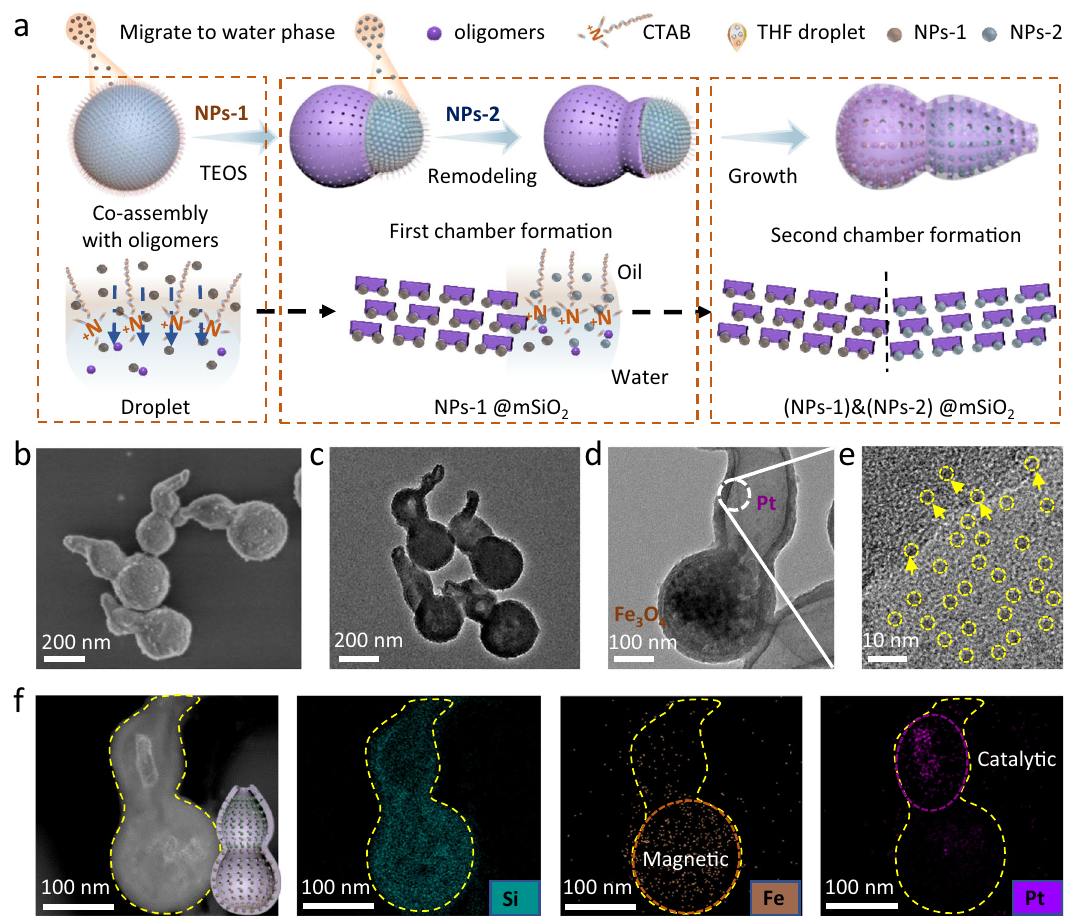
Fig. 4 | Selectively in situ assembly of different functional units. a Schematic illustration of the selective in situ loading of hydrophilic nanoparticles in different chambers. b SEM, c – e TEM,and f element mapping images of the